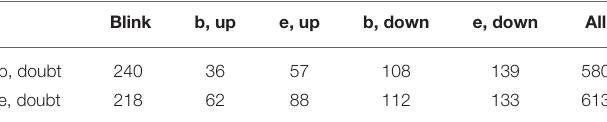
TABLE 7 | Emblem/doubt—frequency of items from the gaze class.